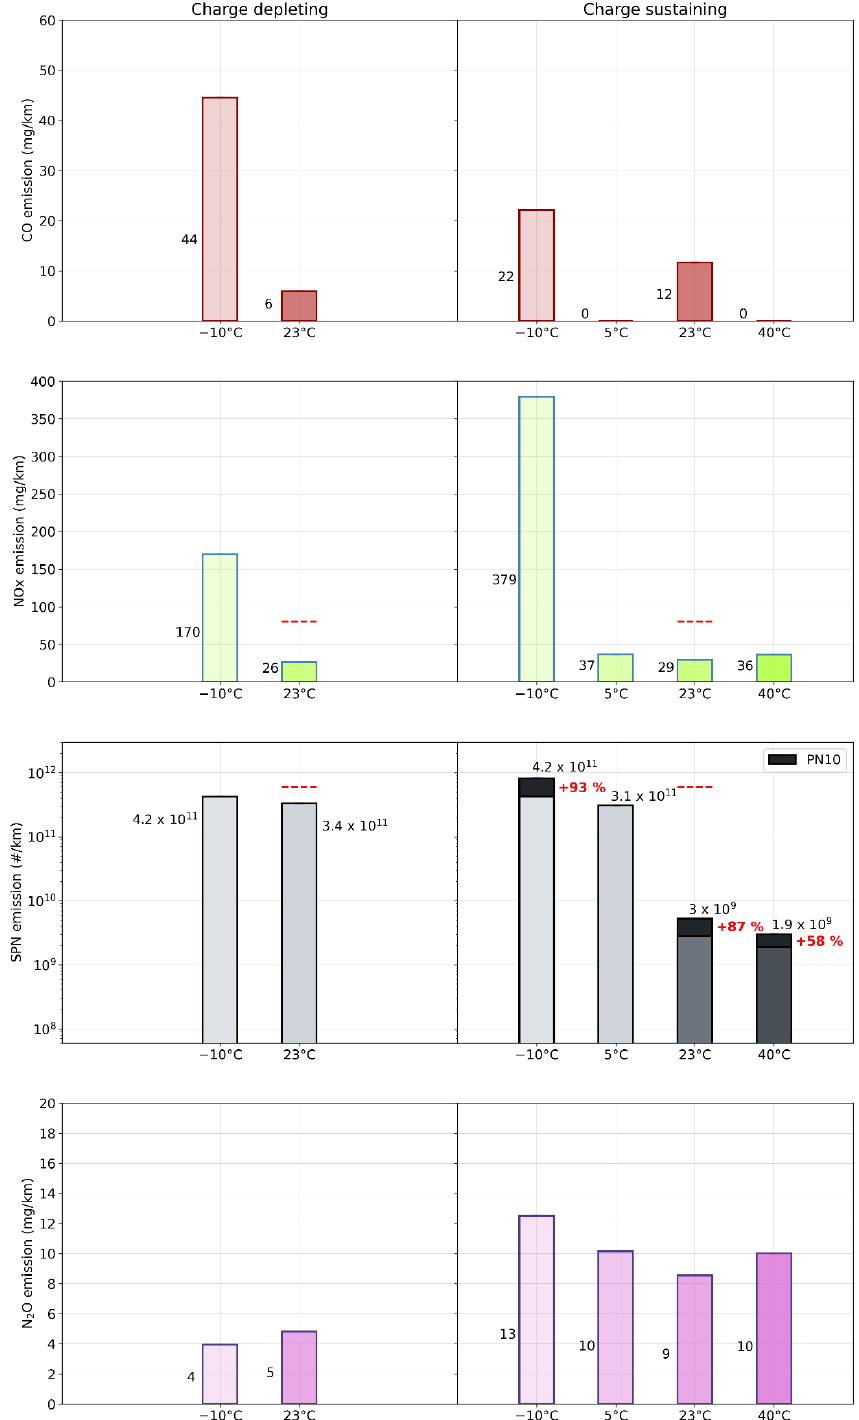
Figure 5. Emissions of regulated pollutants and N 2 O on WLTC tests as a function of temperature. Emissions at 23 °C are the same of those reported in Figures 1 and 3 above and have been included just to ease the comparison. CD indicates the cycle in the charge depleting sequence, started with a battery initial state of charge (SOC) equal to 100%, in which the internal combustion engine ignited for the first time (4th at 23 °C , 1st at −10 °C); CS indicates the cold start charge sustaining cycle performed after the battery depleting sequence, i.e., starting with the minimum SOC. All tests were performed in the default user selectable mode of operation. See Methods section for additional details.